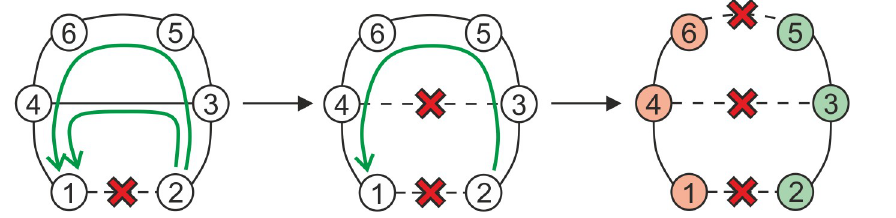
Fig 3. An example of cycles and their